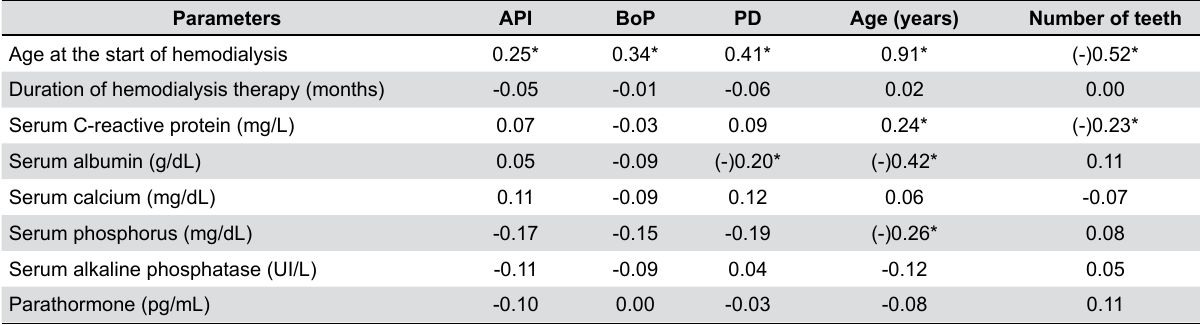
Table 4- Spearman's rank correlation between the investigated